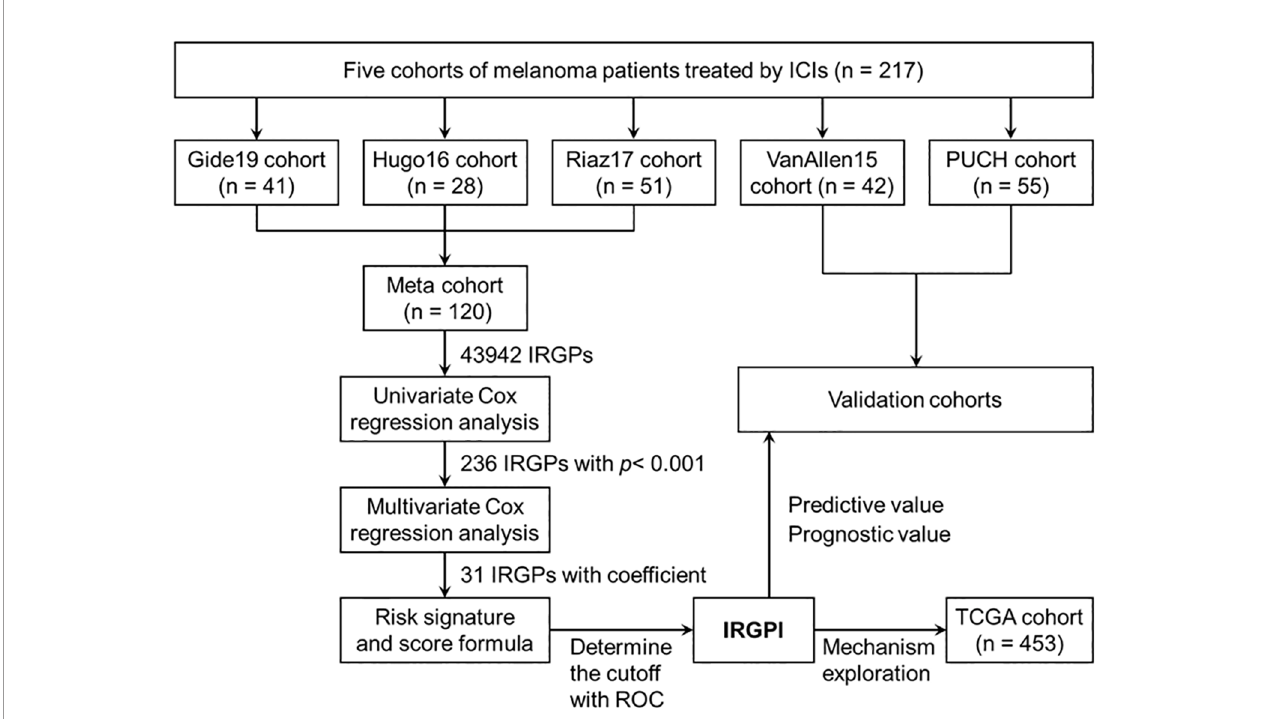
FIGURE 1 | The fl owchart showing the scheme of this